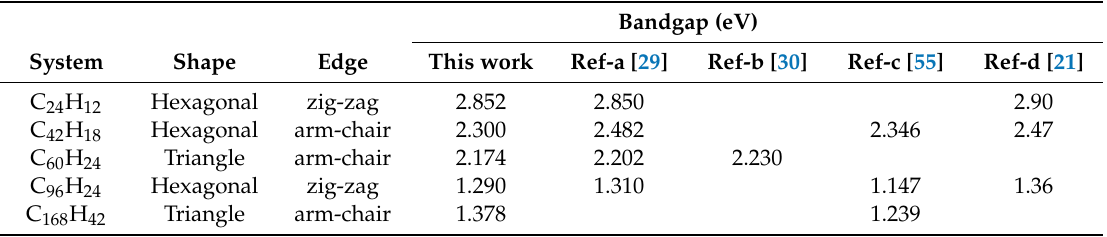
Table 2. Comparing the various GQD bandgaps from our DFT calculations with those from other works using different models.